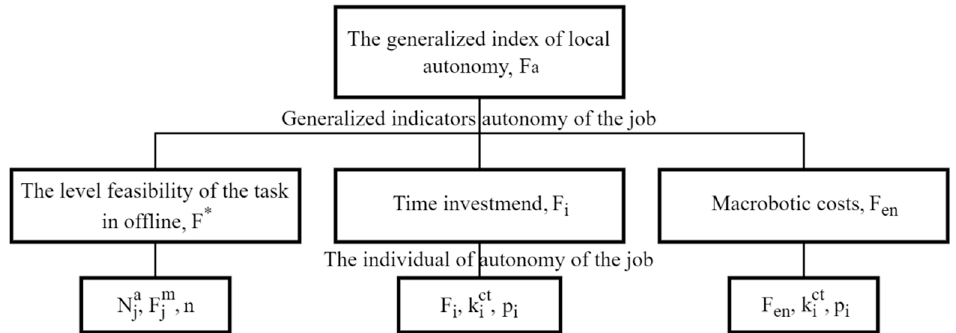
Figure 14. A block diagram of the definition of generalized and individual indicators of the autonomy of performing operations of a robotic platform.